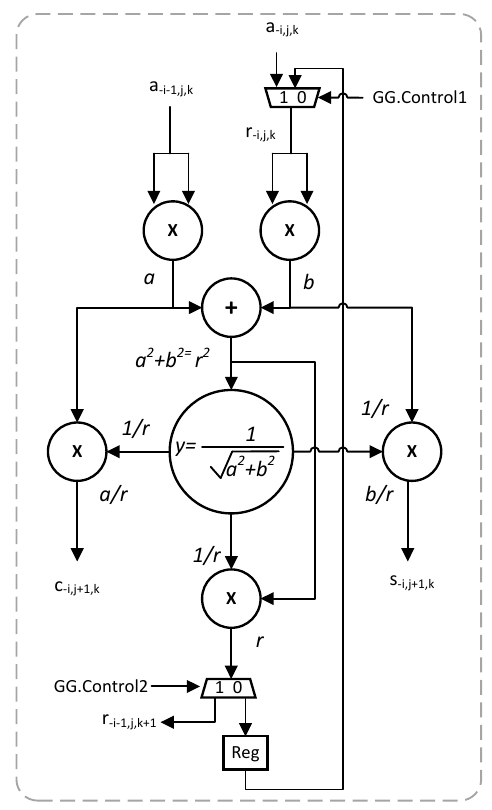
Figure 3. Architecture of Givens Generation (GG)